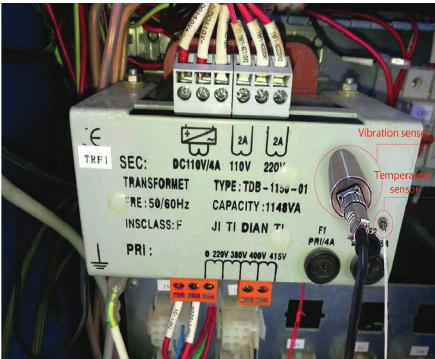
Figure 2: Vibration sensor and temperature sensor installation point.